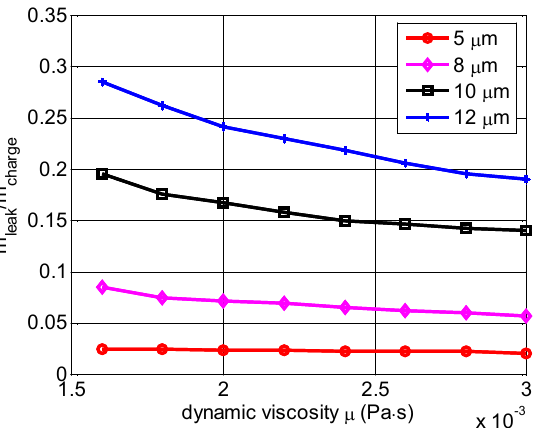
Figure 10. The mass leakage effect on dynamic viscosity coefficient for different seal gap heights .